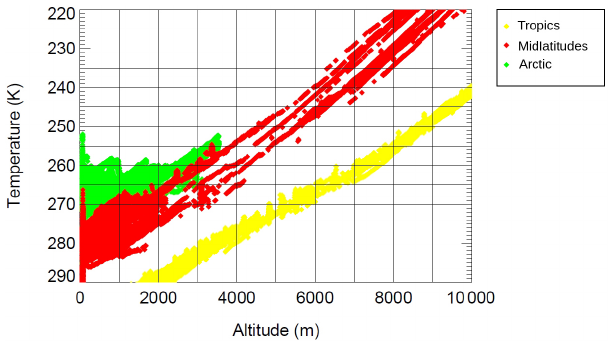
Figure 14. Temperature vs. altitude for the field campaigns VERDI and RACEPAC (Arctic), COALESC (midlatitudes) and ACRIDICON–CHUVA (tropics). The profile differs due to the varying